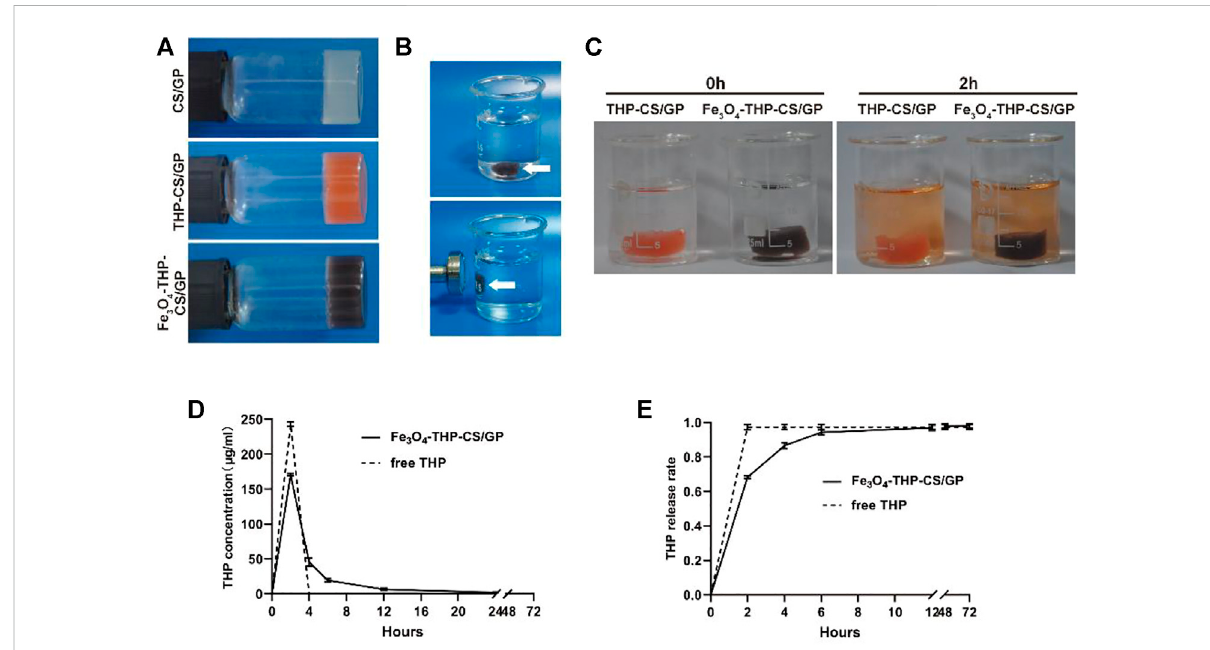
FIGURE 1 Appearance and characteristics of Fe 3 O 4 -THP-CS/GP. (A) Liquid gel changes into a solid and stably sticks to the wall of the container. CS/GP gel is milky white, orange with THP, and black with Fe 3 O 4 -MNP. (B) When the external magnetic fi eld was applied, the Fe 3 O 4 -THP-CS/ GP gel at the bottom of the container was quickly adsorbed to the sidewall, demonstrating the gel ’ s good magnetic targeting performance. (C) Color of the medium containing THP-CS/GP and Fe 3 O 4 -THP-CS/GP gradually changed to orange in 2 h (the color of THP solution is orange), whichshowedsustained releaseperformance ofthe gel. (D) Drugconcentrationcurve inthemediumofFe 3 O 4 -THP-CS/GP andfree THP solution. (E) Cumulative release rate curve of Fe 3 O 4 -THP-CS/GP and free THP solution.